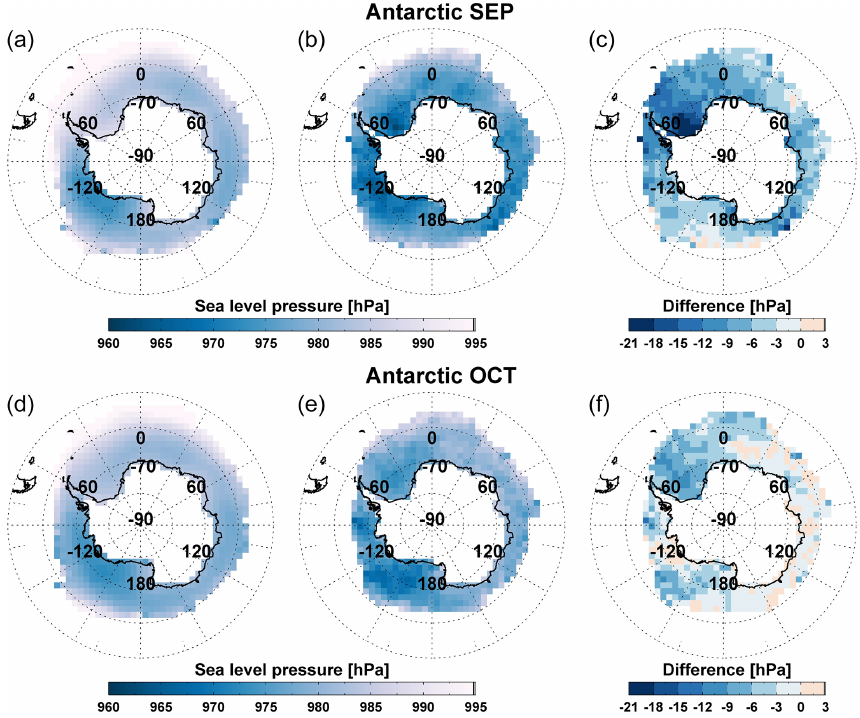
Figure 5. As Fig. 4 but for the Antarctic in September (a–c) and October (d–f)